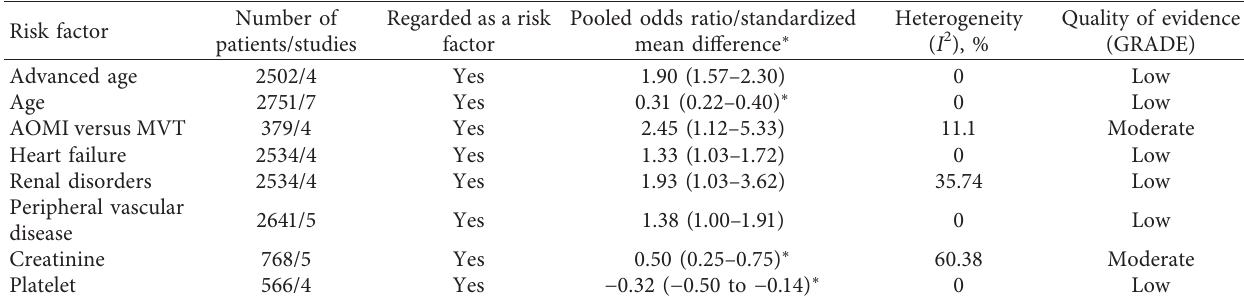
Figure 4: Forest plots for significant preoperative risk factors for short-term postoperative mortality of AMI after laparotomy with data available in at least four studies (laboratory tests). FE: fixed effect; RE: random effect. (a) Creatinine (continuous variable) and (b) platelet (continuous variable). Table 4: Summary finds of preoperative risk factors eligible for